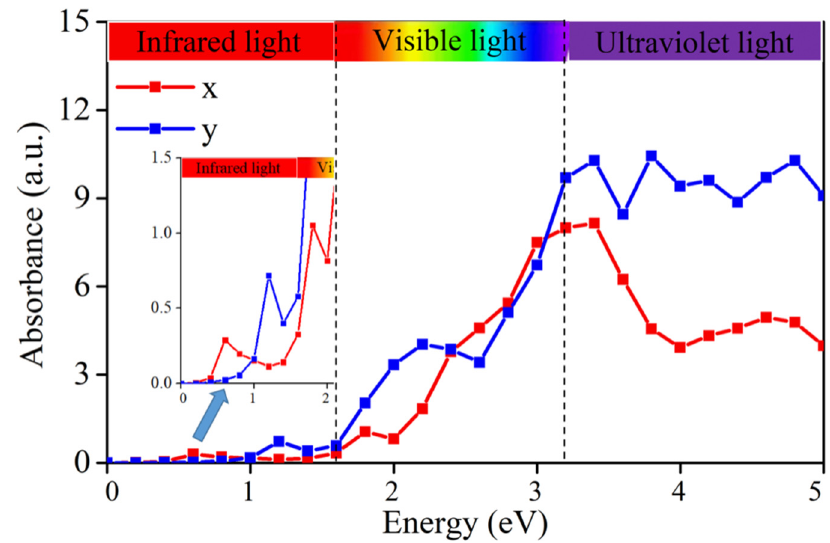
Figure 3. Optical absorption spectrum of two-dimensional